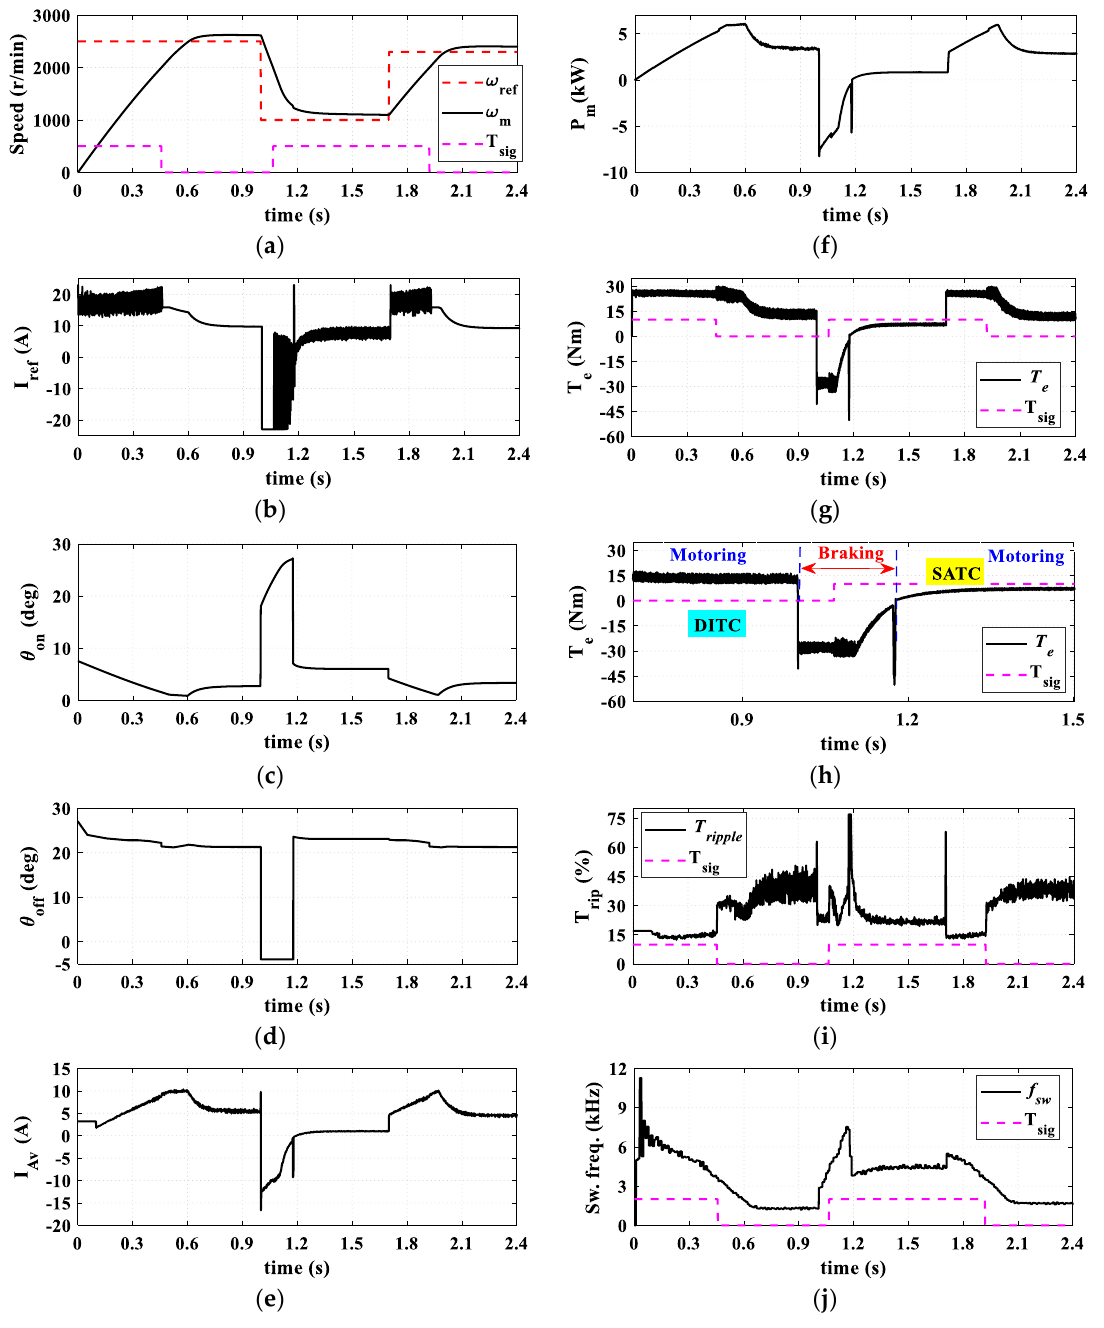
Figure 14. The simulation results under starting with EV acceleration and deceleration. ( a ) The motor speed; ( b ) the reference current; ( c ) the variation of the turn on angle; ( d ) the variation of the turn off angle; ( e ) the average current; ( f ) the mechanical output power; ( g ) the total electromagnetic torque; ( h ) zoom on electromagnetic torque; ( i ) the torque ripple; ( j ) the switching